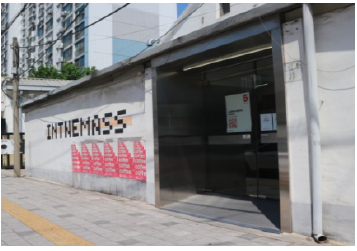
Figure 7. In the Mass (2018, Seoul, Korea).